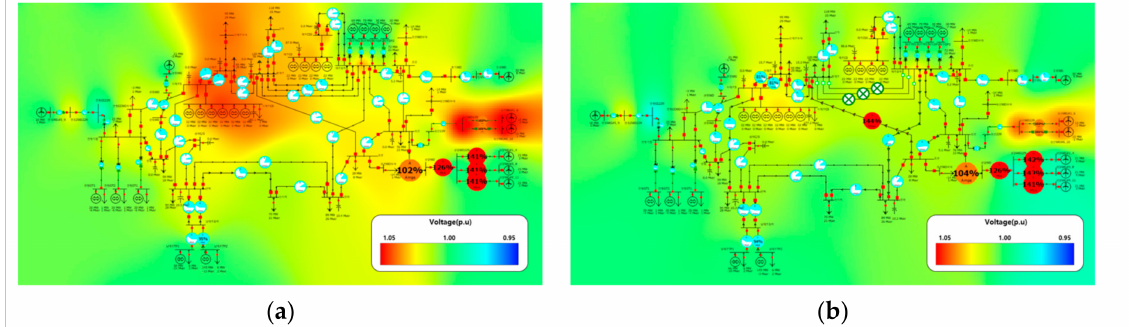
Figure 6. Review of case study with summer deterministic scenario: ( a ) Results of security analysis pre-N-1 contingency; ( b ) results of security analysis post-N-1